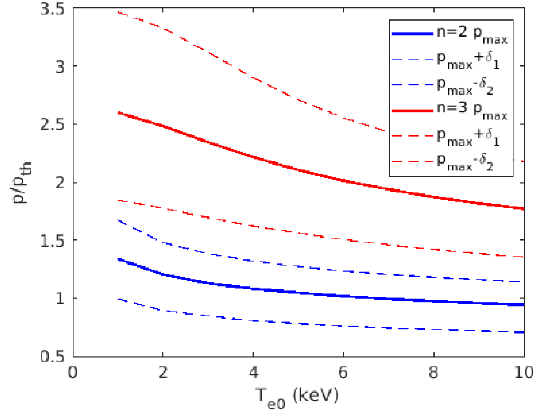
Fig. 3. Momentum value (normalised to thermal momentum) at the maximum of the radiation function 𝛽𝑒𝑥𝑝 (− ∫𝛼𝑑𝑅) (solid lines) for the 2 nd (blue) and the 3 rd (red) harmonics. Dashed lines correspond to the width at half height of the radiation